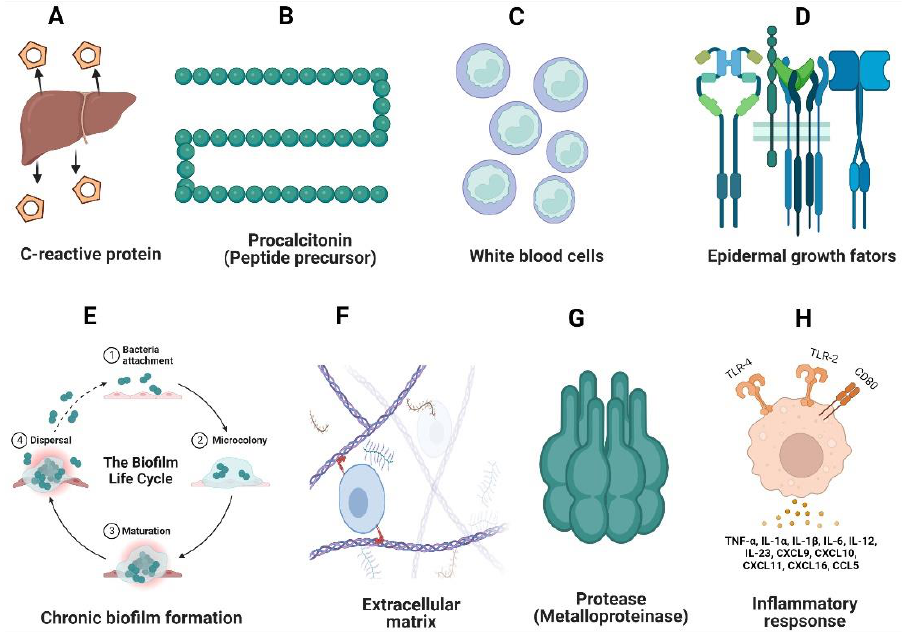
Figure 3. Acute ( A – D ) and chronic ( E – H ) biomarkers during DFU infections. C-reactive proteins and procalcitonin are primary proteins whose differential expression indicates the onset of DFU infections ( A , B ). White blood cells (WBCs) typically express information about bacterial infections ( C ). Epidermal growth factors highlight lower neutrophil expression ( D ), indicating decreased re-epithelization during wound healing. Biofilm formation by opportunistic pathogens ( E ) and reduc-